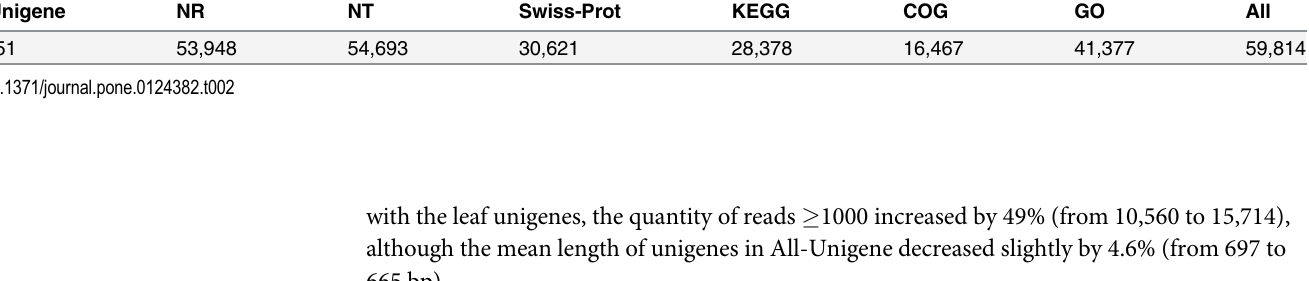
Table 2. Statistics of annotation results of All-Unigene sequences. All-Unigene